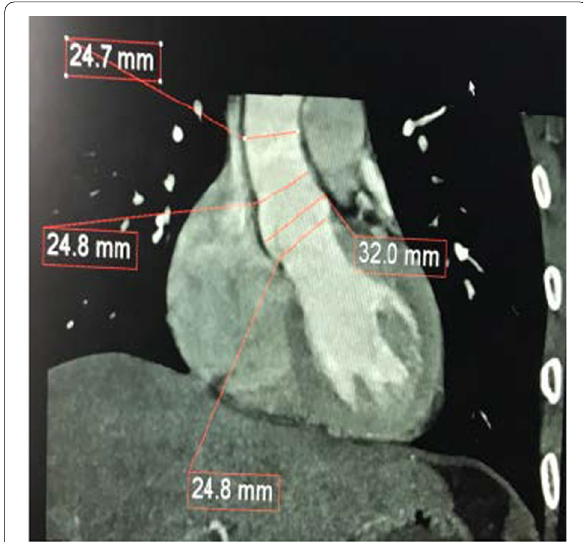
Fig. 1 ECG‑gated cardiac computed tomography (coronal view) in a healthy 32‑year‑old man